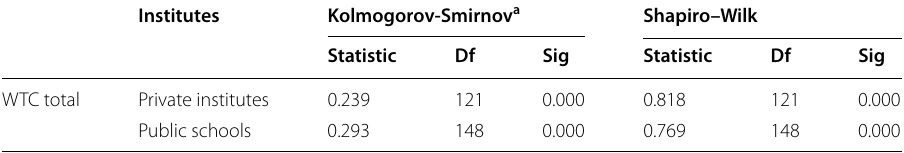
Table 7 Mann–Whitney U test results